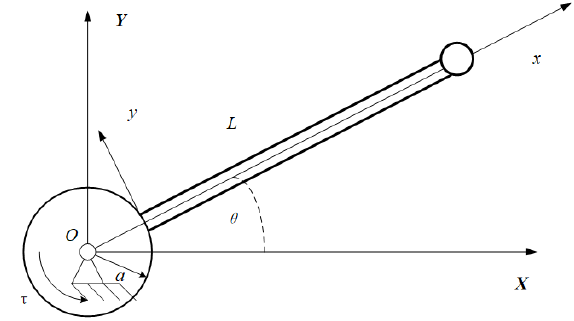
Figure 1. Rotating cantilever beam system with a free end